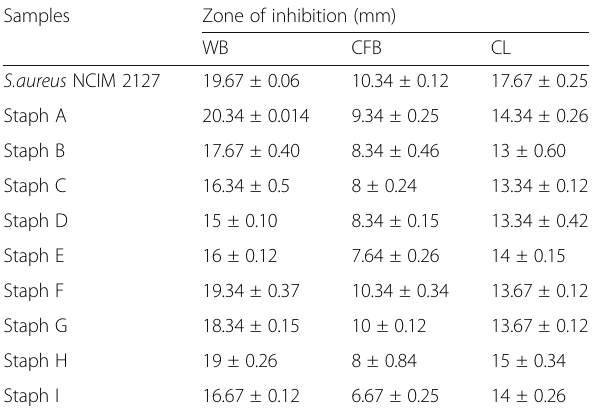
Table 3 Diameters of growth inhibition zone of MDR microorganisms by WB, CFB, and CL